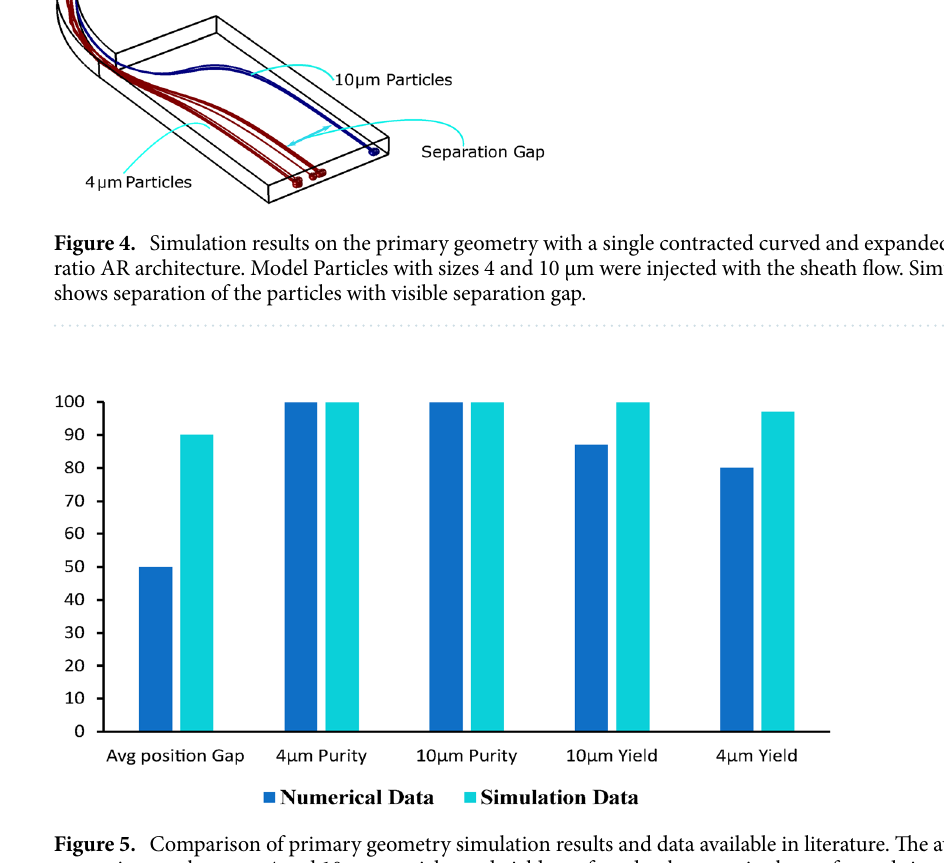
Figure 5. Comparison of primary geometry simulation results and data available in literature. The average separation gap between 4 and 10 µm particles and yield was found to be more in the performed simulation. However, purity of both cell sizes was similar to the reported